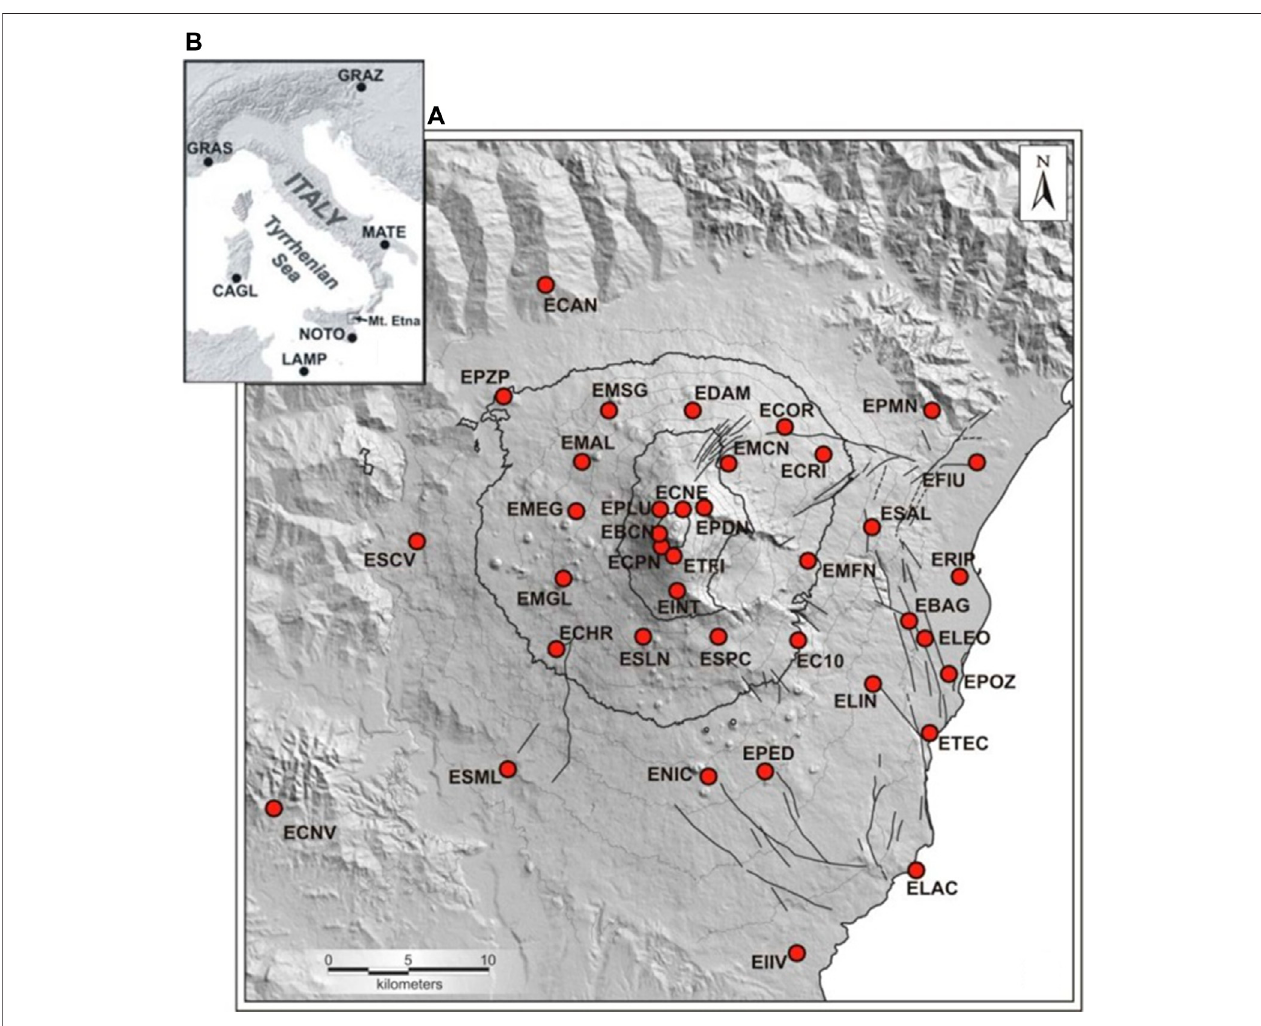
FIGURE 2 | (A) The permanent GPS stations over Mt. Etna volcano. 1,000 m contour lines are shown. (B) IGS stations included in the International Terrestrial Reference Frame (ITRF).